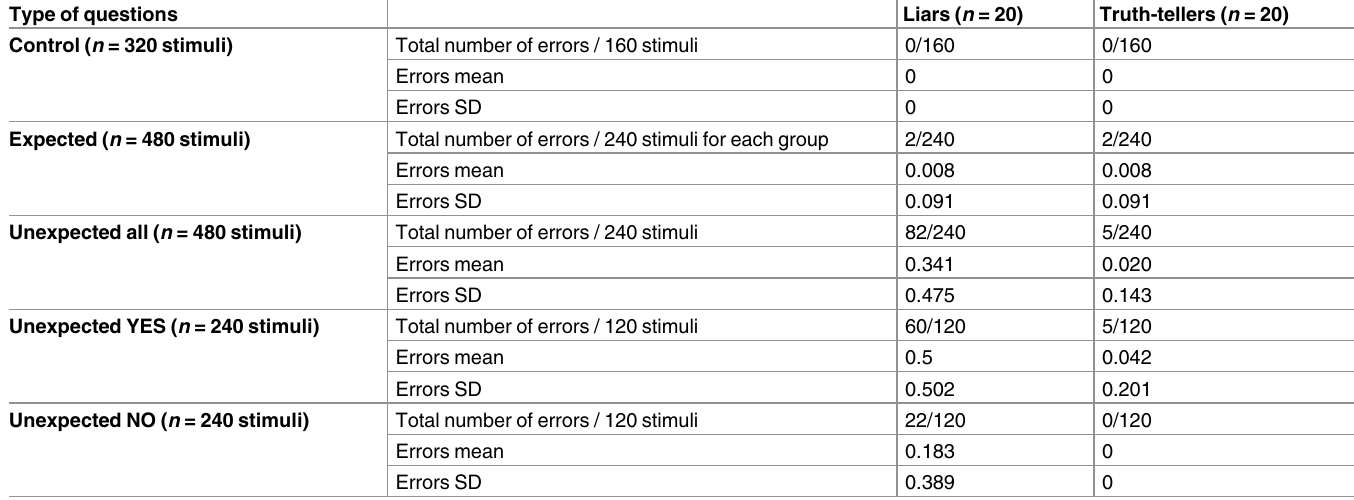
good results. To address the effects of culture on the generalization of results, we tested a sam- ple of 20 participants native speakers of German in Du¨sseldorf (10 truth-tellers and 10 liars; average age = 29.5 years; males = 9/20) with questions in German. Participants provided informed consent before the experiment. Results from this group were evaluated using the model originally trained on the 40 Italian participants. The classification accuracy was the fol- Table 8) indicates that the proportion of errors in liars and truth-tellers is comparable in the two groups (Italian n = 40 and German n = 20) with results for liars of t = -1.4, p = 0.17 (Cohen’s d = -0.49, BF = 0.64) and results for truth-tellers of t = 0.66, p = 0.52 (Cohen’s d = 0.28, BF = 0.43).